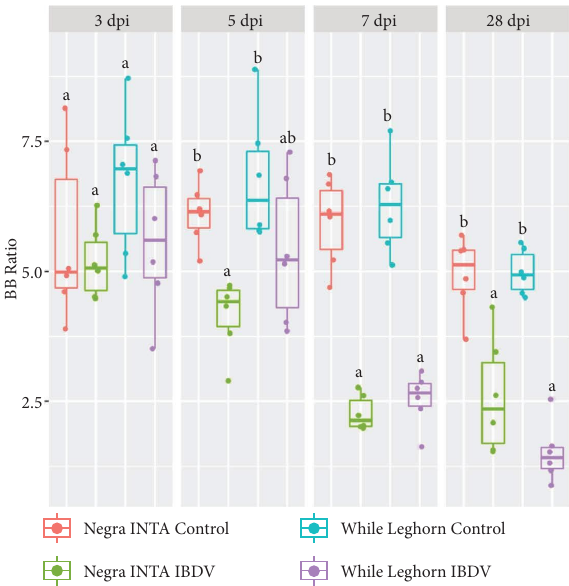
Figure 1: Bursa/body weight (BB) ratios of Negra INTA and White Leghorn chickens infected with IBDV. Chickens were sacrifced and weighted at diferent times postinfection. Bursae were extracted and also weighted. Individual BB ratios were determined by the formula (bursa weight (g)/body weight (g)) × 1000. Te box plots represent data distribution. Diferent letters indicate signif- icant diferences among groups (one-way ANOVA test and Tukey post-hoc test, p < 0 .